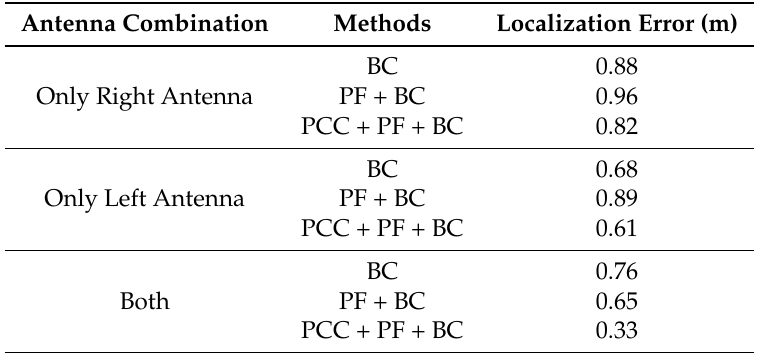
Table 3. Comparison of localization accuracy under different antenna